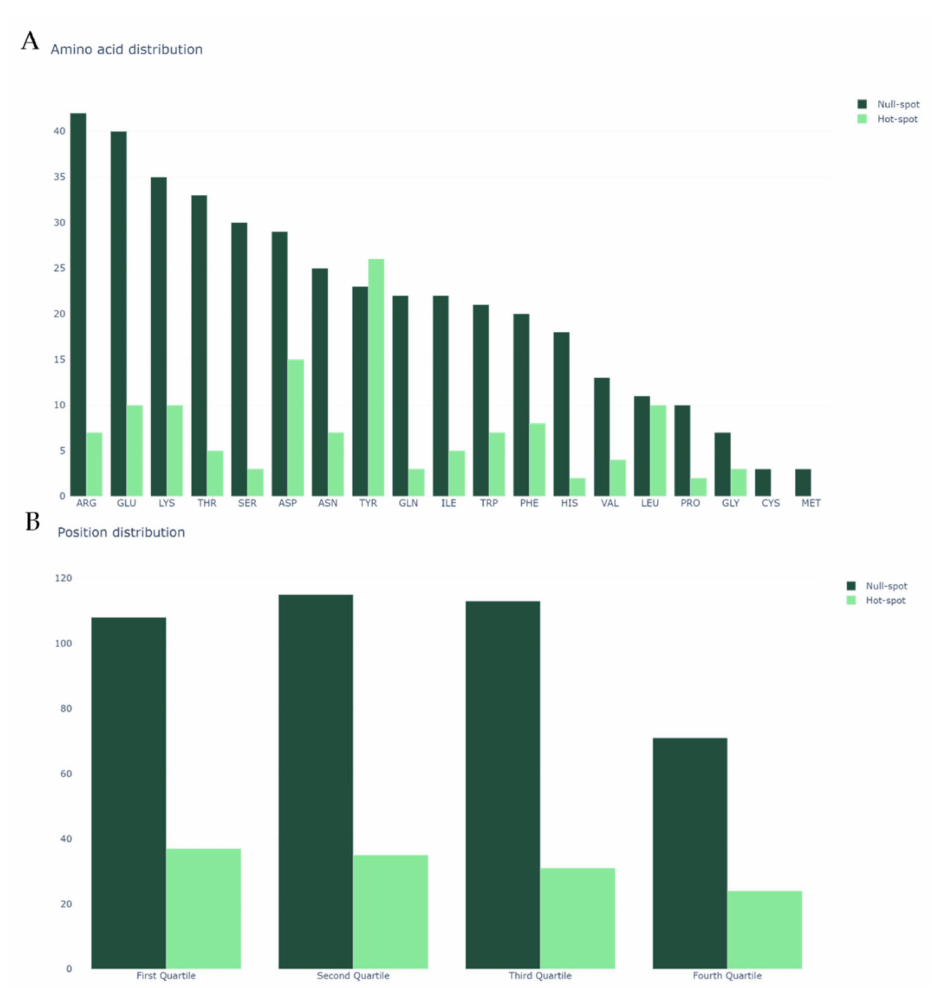
Figure 2. ( A ) Class distribution by amino acid type; and ( B ) class distribution by relative position in the protein sequence. In both plots, the y-axis represents the amino acid